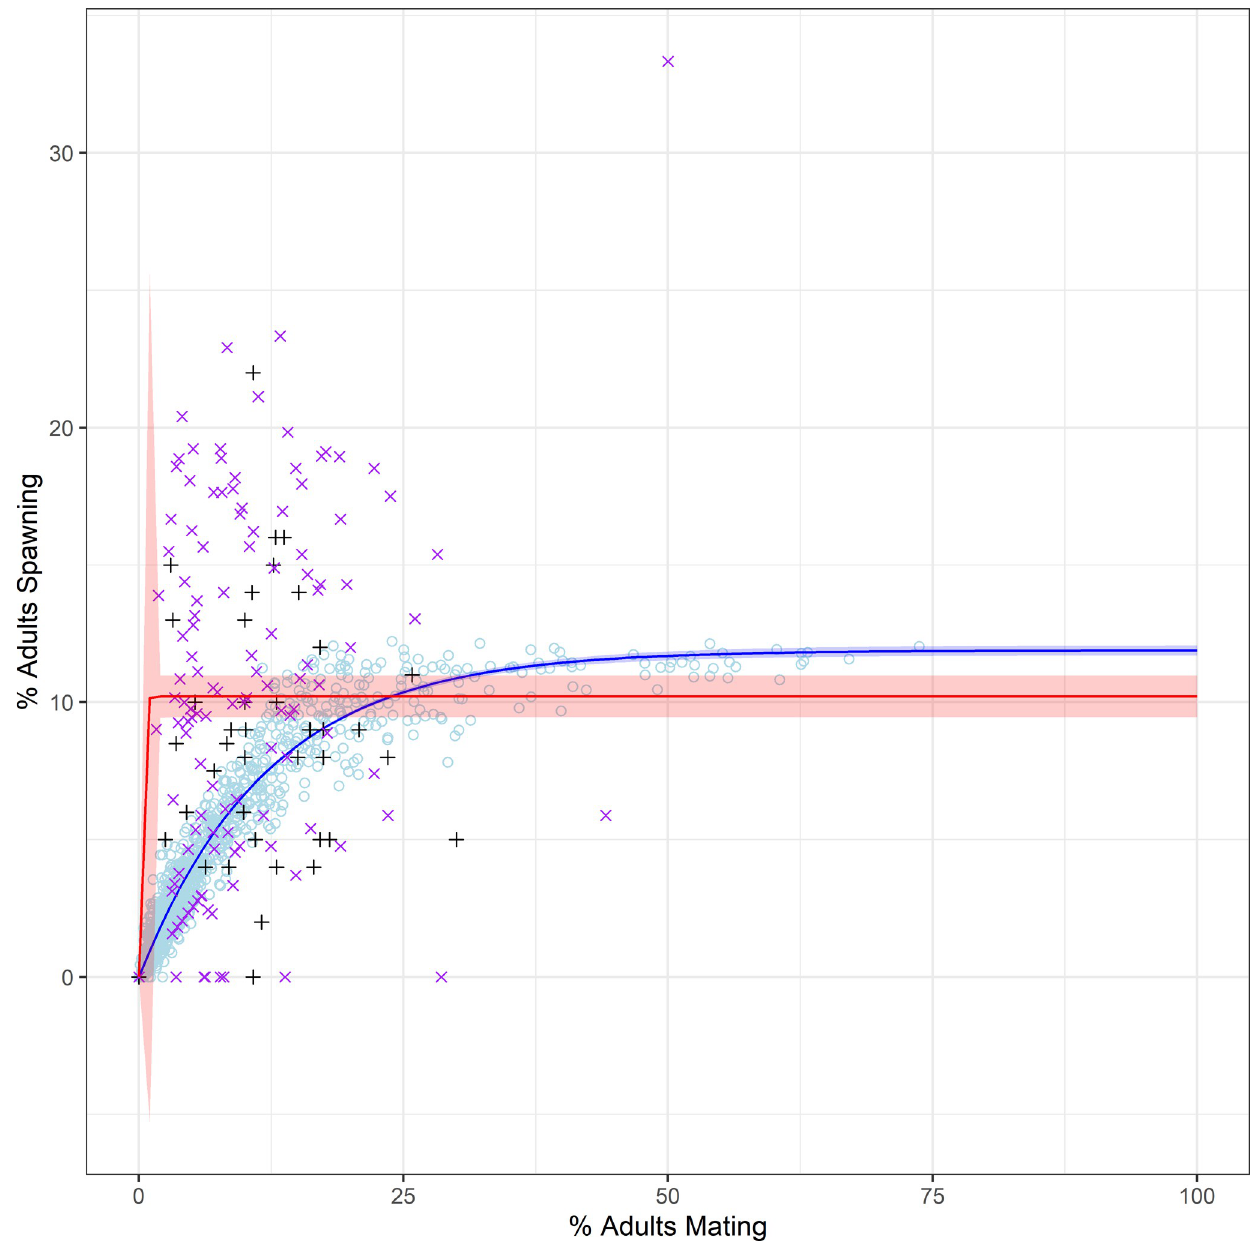
Fig 5. Mating and spawning activity. Relationship between mating and spawning activity across model simulations providing superior fits to empirical data (line and 95% confidence band in red) with logistic dose-response function fit (blue line) and 95% confidence band (blue), relative to empirical observations by Stoner & Ray-Culp [32] (black crosses) and Delgado & Glazer [38] (purple x’s).